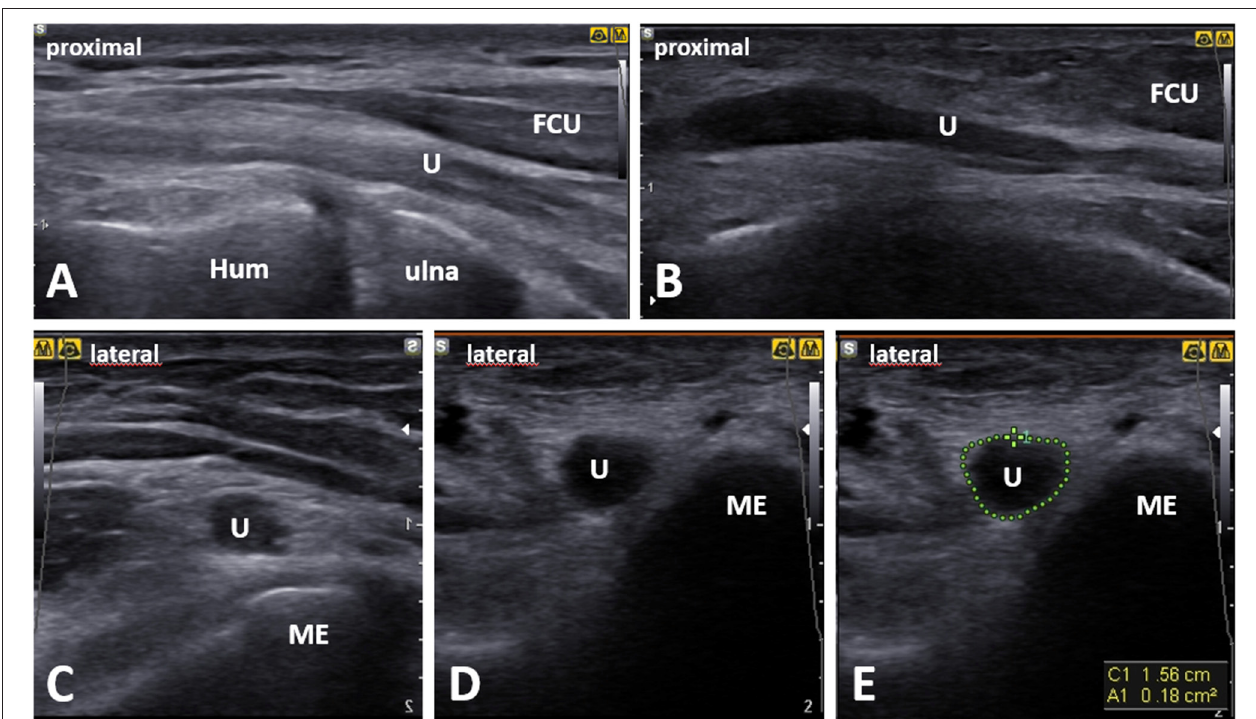
FIGURE 8 | Comparative ultrasound ( US ) imaging of the ulnar nerve ( U ) at the level of the medial epicondyle ( ME ) in a patient with cubital tunnel syndrome. When compared with the normal side. (A) The asymptomatic side in a long axis of the ulnar nerve. (B) The symptomatic side ulnar nerve shows swelling (“bottle neck appearance”) proximal to the cubital tunnel inlet in long-axis. (D,E) In short axis, compared with the normal side (C) , the ulnar nerve on the symptomatic side shows enlargement in its cross-sectional area of 18 mm 2 outlined using the direct US tracing method ( green dotted line ). Hum, humerus; FCU, flexor carpi ulnaris muscle.